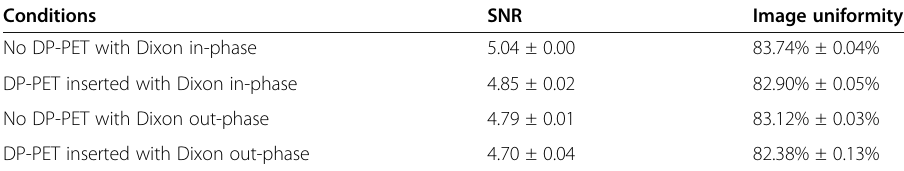
Table 4 SNR and image uniformity under different conditions Conditions